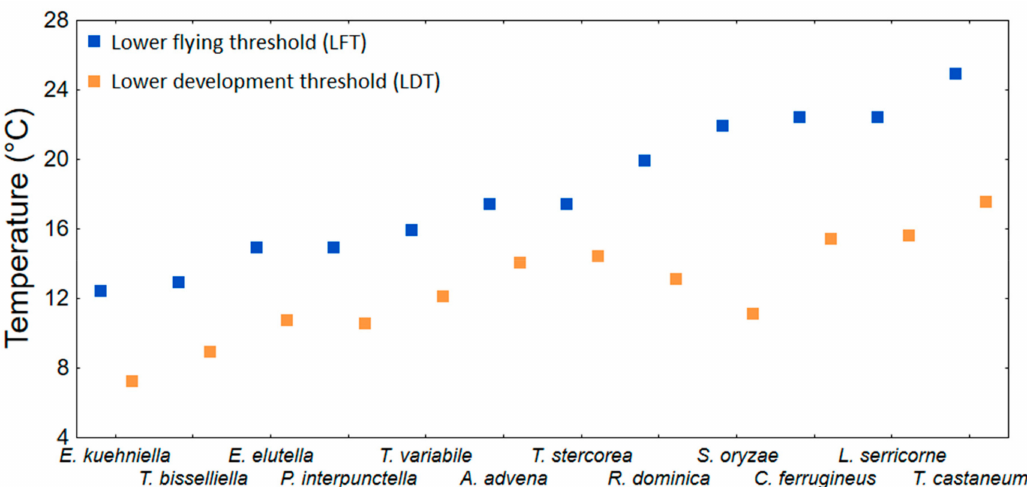
Figure 3. Comparison of lower flying (LFT) and development thresholds (LDT) of moth and beetle species for which both variables are available. (The lowest LDT value from Tables 2 and 3 was used for each species).